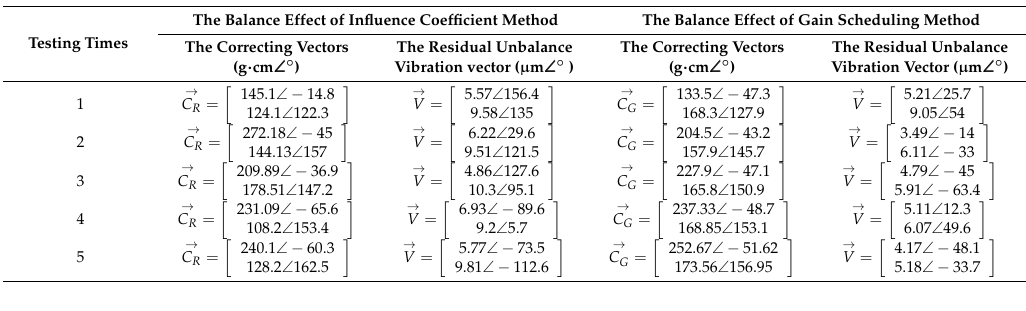
Table 3. The balance effect